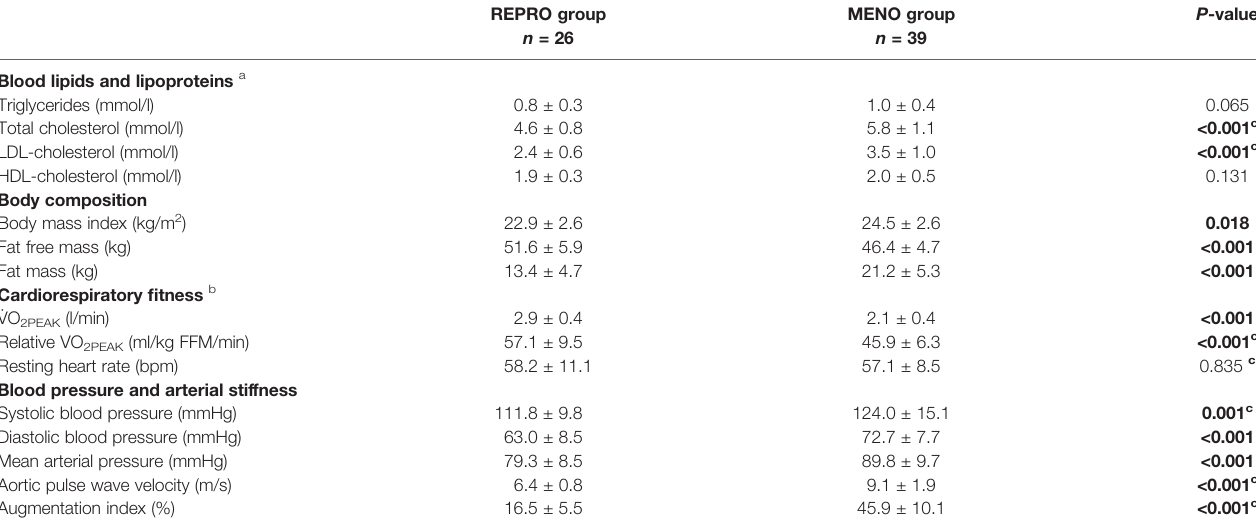
TABLE 2 | Parameters of cardiovascular